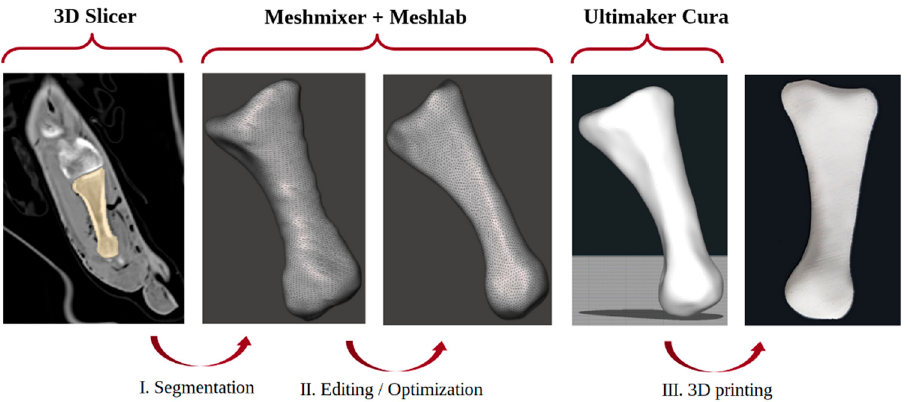
Figure 1. Graphical representation of the methodology.